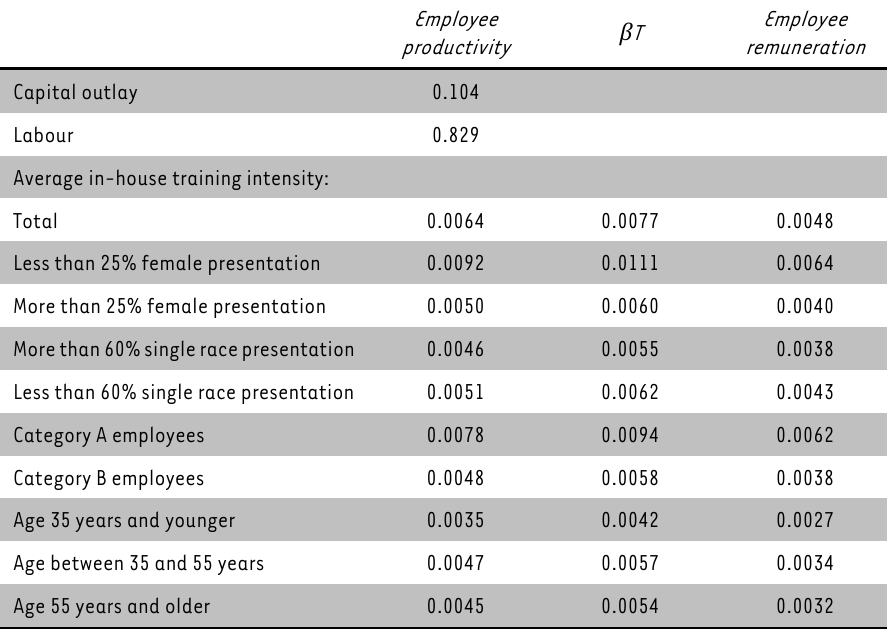
TABLE 4: In-house training intensity estimates (for the various diversity dimensions)